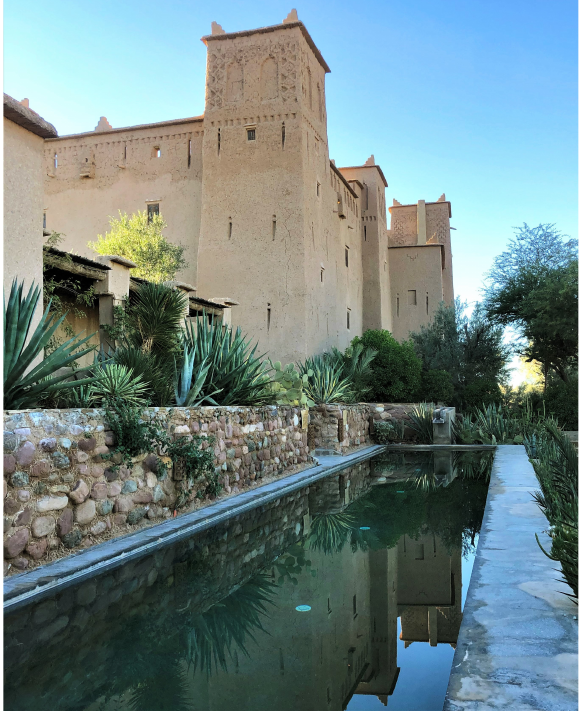
Figure 7. “Kasbah Aït Ben Moro”, Taskoukamt, Skoura.